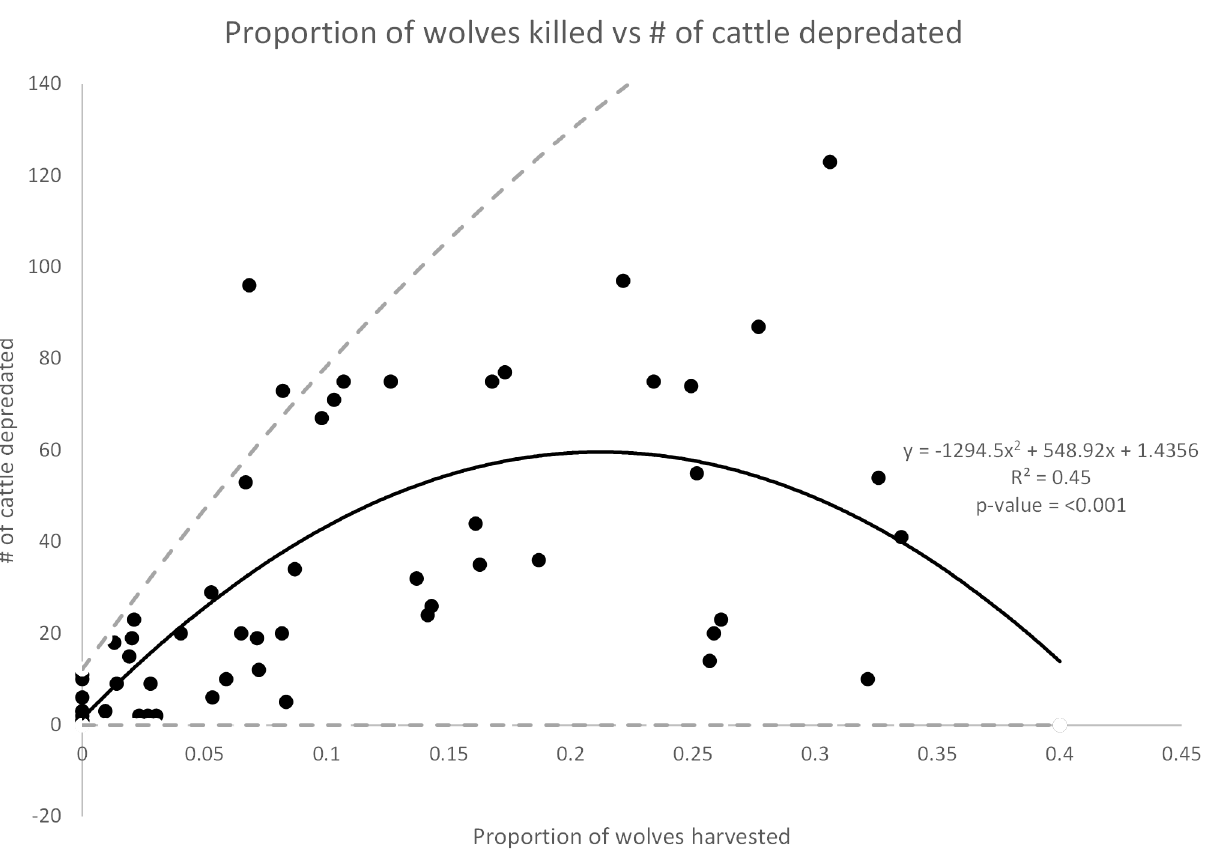
Figure 3. The proportion of wolves killed vs cattle depredated. Proportion of wolves killed the previous year versus the number of cattle depredated the following year. The dashed lines show the upper and lower limits of the 95% confidence interval for the best fit